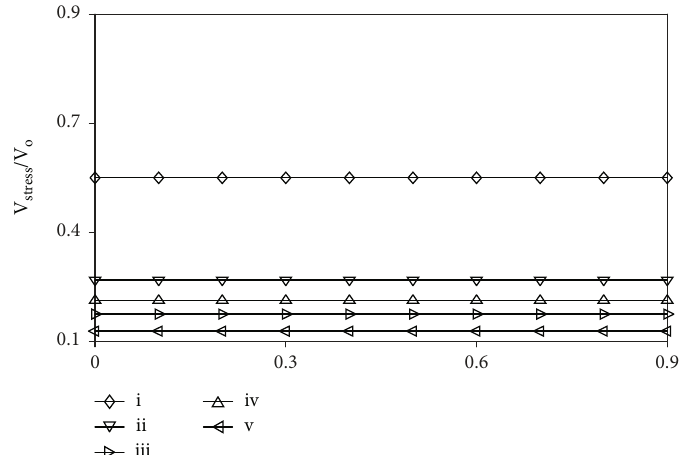
Figure 8: Voltage stress comparison of MOSFET. (i) Converter in [24]. (ii) Converter in [27]. (iii) Converter in [29]. (iv) Converter in [30]. (v) Proposed converter.